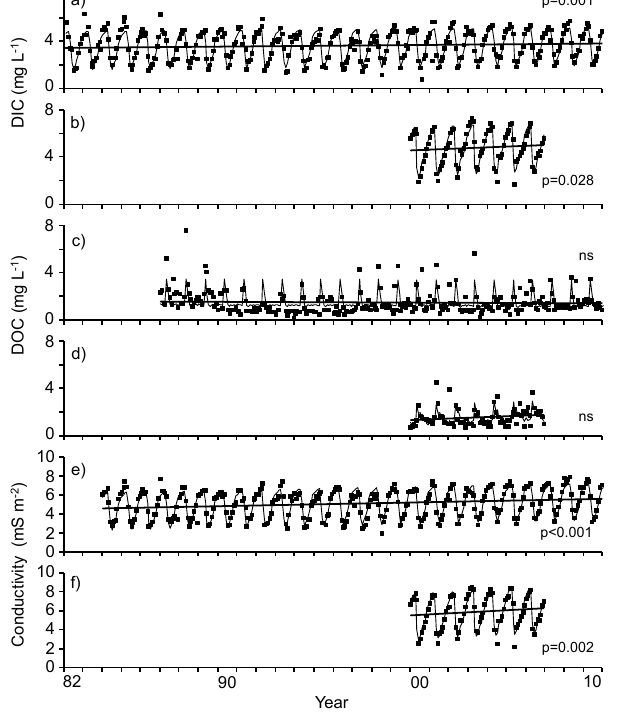
Fig. 4. Long-term trends for stream 6 (Abiskojokka) and stream 3 (Pessijokka) in DIC (a) and (b) , DOC (c) and (d) , and conductivity (e) and (f) . The abbreviation ns denotes not significant trend.